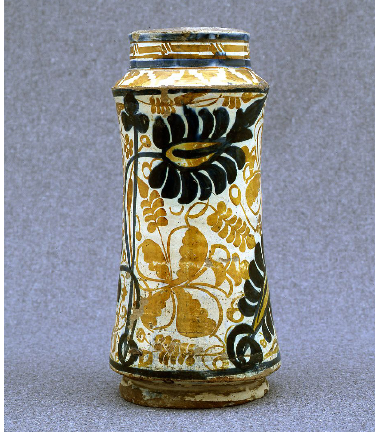
Figure 2. Mechanism of formation of silver nanoparticles from the chemical reduction in solution of the AgNO